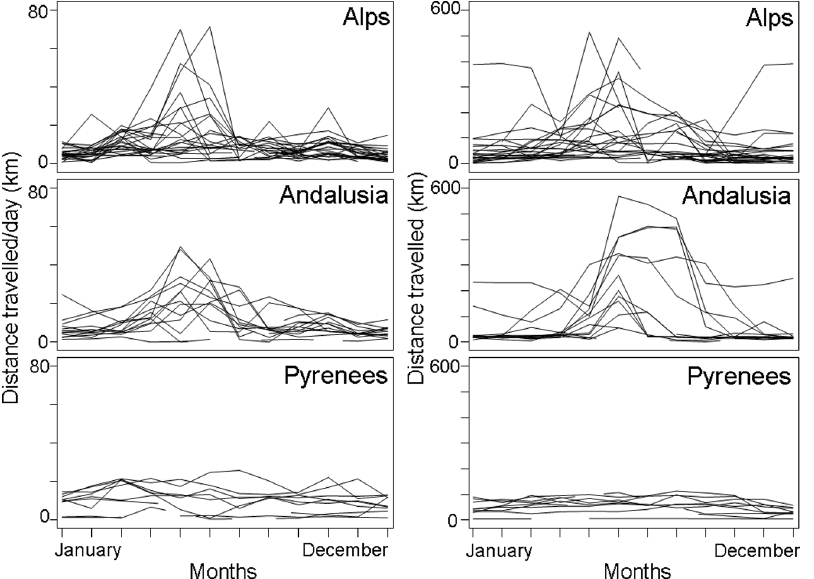
doi:10.1371/journal.pone.0065857.g002 Pyrenees (Pyrenees and Alps : t =3.78, d.f. = 45, p =0.0005; Pyrenees and Andalusia: t= 4.35, d.f. = 45, p , 0.0001).